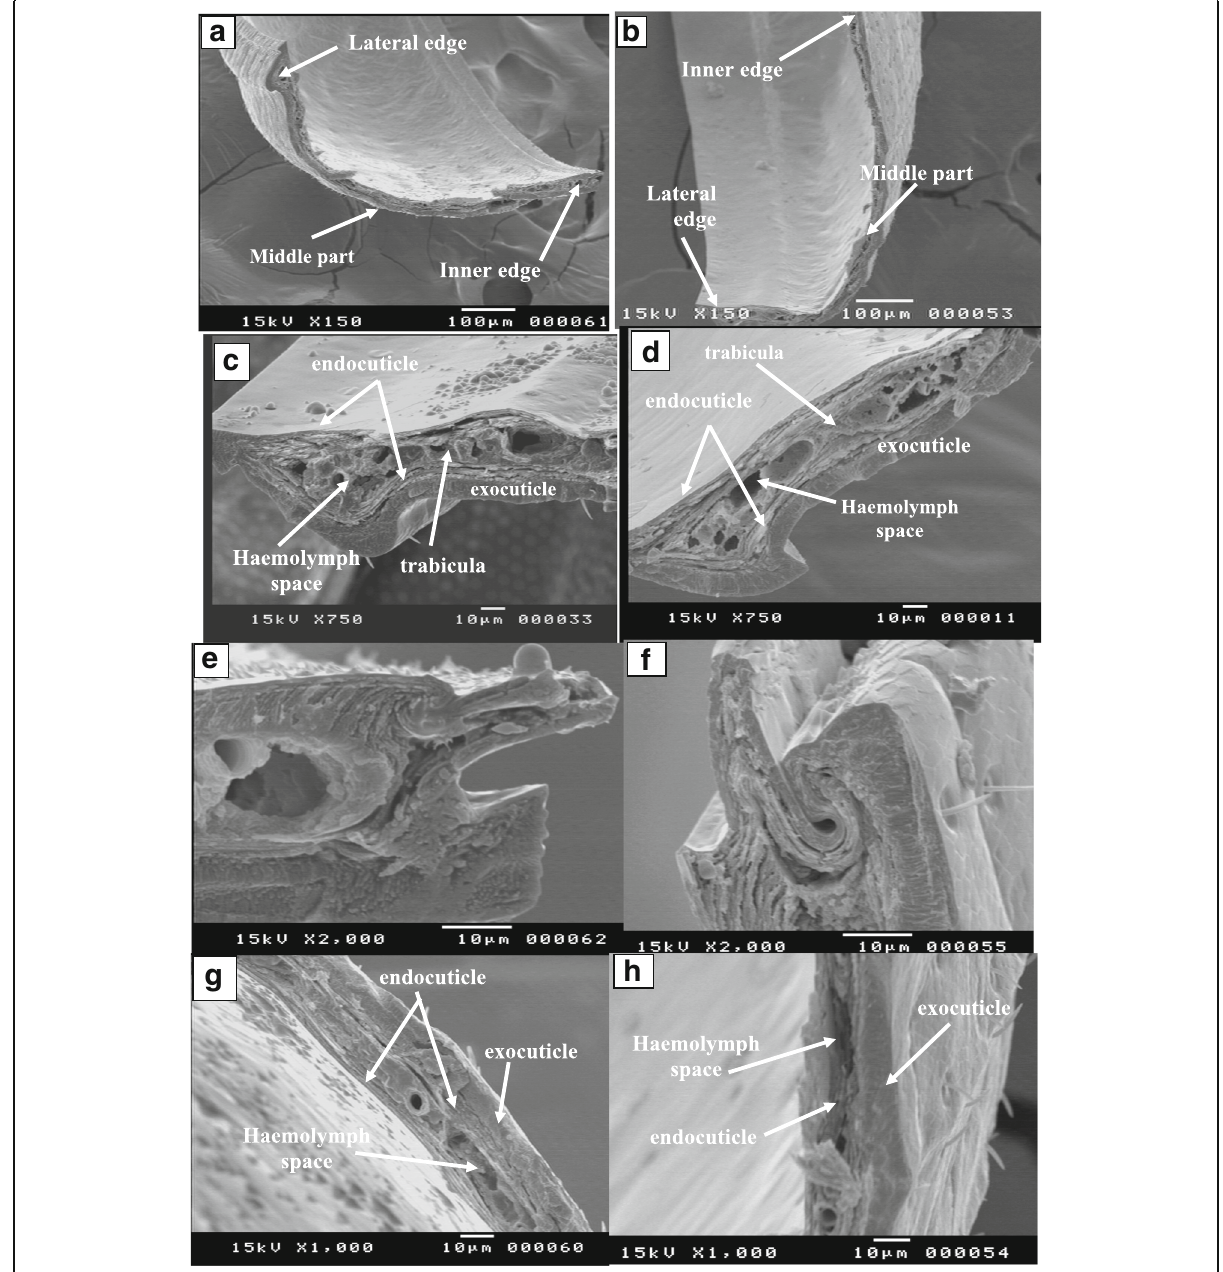
Fig. 6 Scanning electron microscope (SEM) images of cross section of elytron of ( a , c , e , g ) Tribolium castanaeum ; ( a ) whole cross section, ( c ) lateral edge, ( e ) inner edge, ( g ) middle part; ( b , d , f , h ) Tribolium confusum ; ( b ) whole cross section, ( d ) lateral edge, ( f ) inner edge, ( h ) middle part, showing dorsal (upper) and ventral (lower) parts of elytrons were separated by haemolymph space created by trabeculae, the thickness of the elytrons are different among two